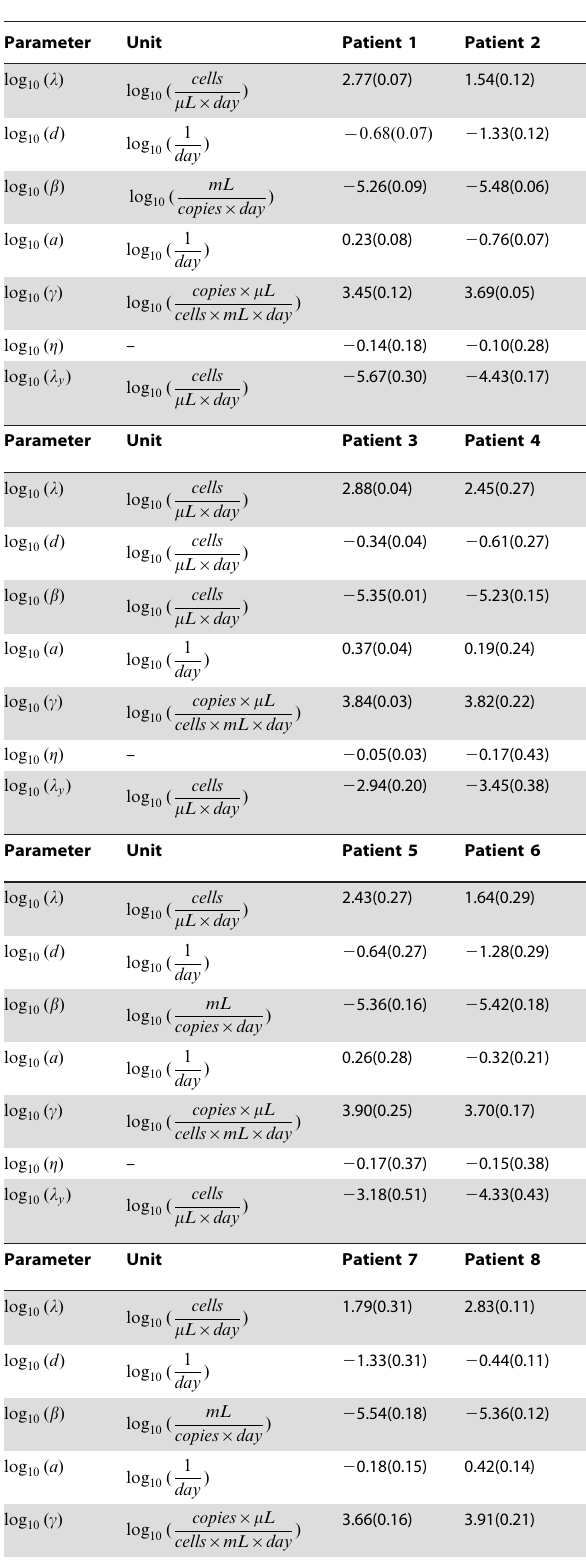
Table 2. Parameter identification results for each patient, reported as mean(standard